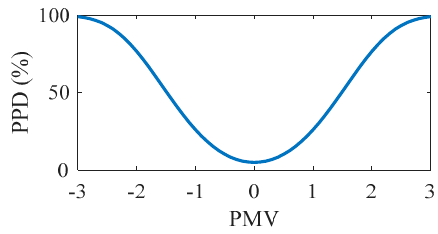
Figure 5. Relationship between the PMV and the PPD.